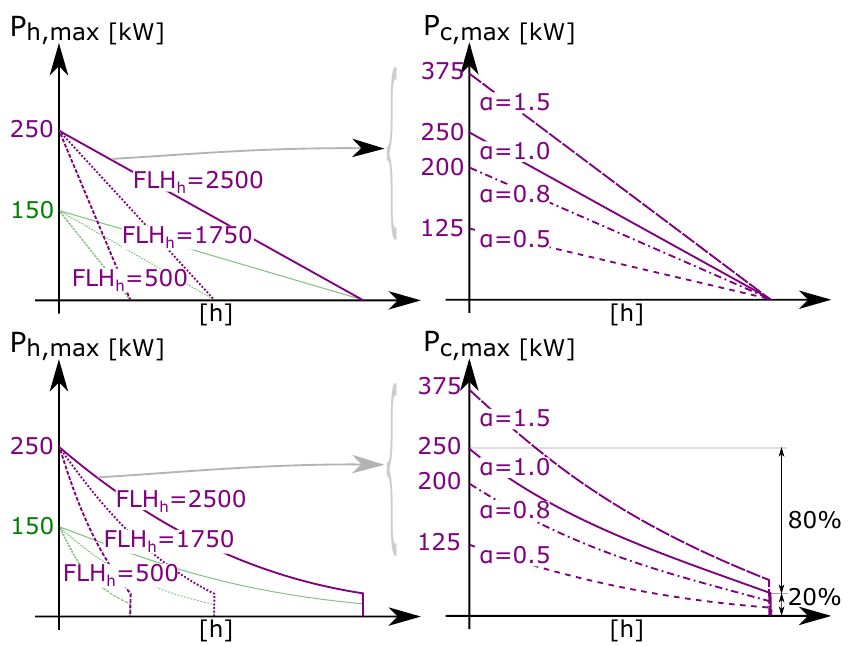
Figure 6. Heating (left) and cooling curves (right) with triangular (top) and logarithmic (bottom) shapes. The represented cooling curves correspond to the heating curve with P h,max = 250 kW for different α